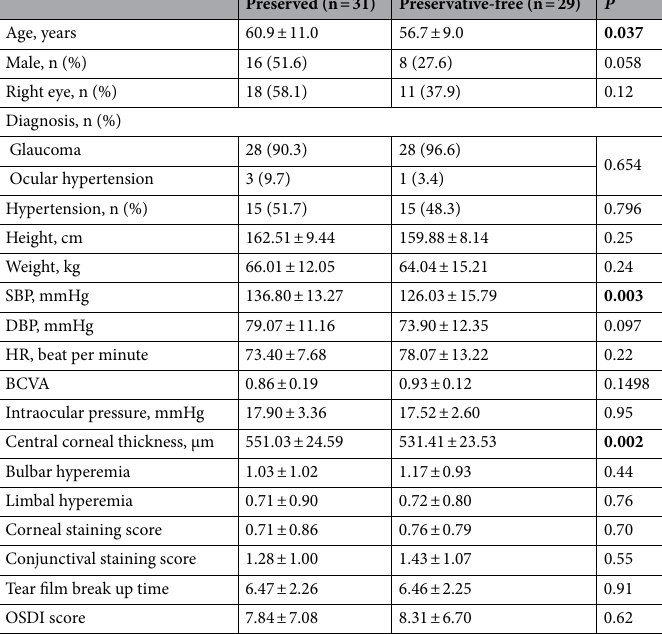
Table 1. Comparison of demographics and baseline characteristics between included patients. SBP systolic blood pressure, DBP diastolic blood pressure, HR heart rate, BCVA best corrected visual acuity, OSDI ocular surface disease index. Significant values with P < 0.05 are indicated in bold.